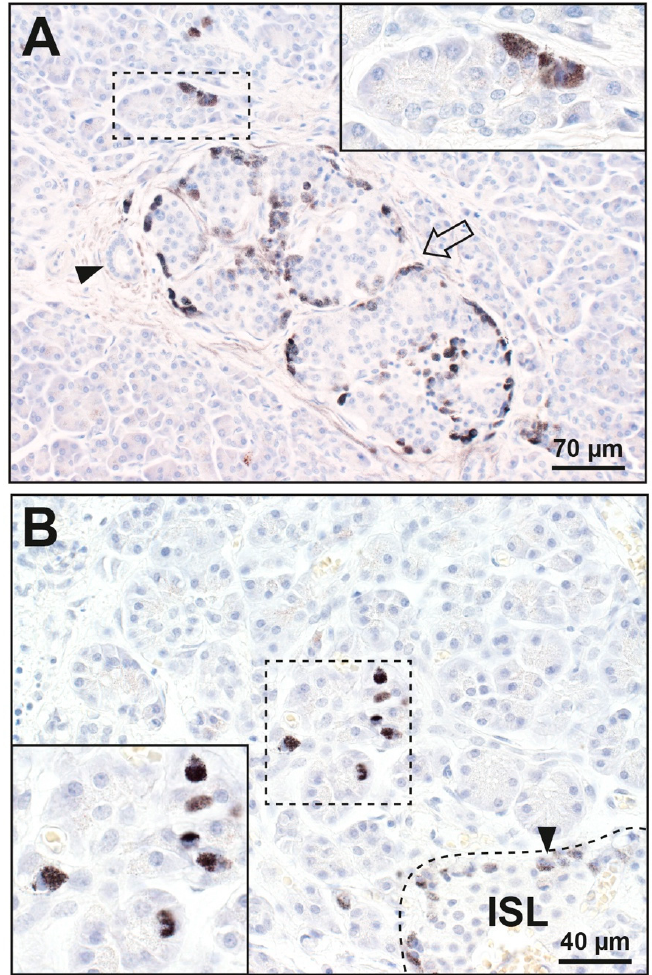
Figure 3. Mercury in pancreatic acinar cells. The areas in the dashed rectangles are shown at higher magnifications in the insets. ( A ) Some acinar cells (e.g., in the inset) contain black mercury grains. A nearby large islet (arrow) has mercury-positive peripheral and internal cells. A small duct (arrowhead) adjacent to the islet does not contain mercury. ( B ) A group of glands (within the dashed rectangle) have acinar cells containing cytoplasmic mercury (inset). A nearby islet (ISL, within the dashed line in the right lower corner) has peripheral cells (e.g., arrowhead) that contain mercury. Autometallography/hematoxylin.